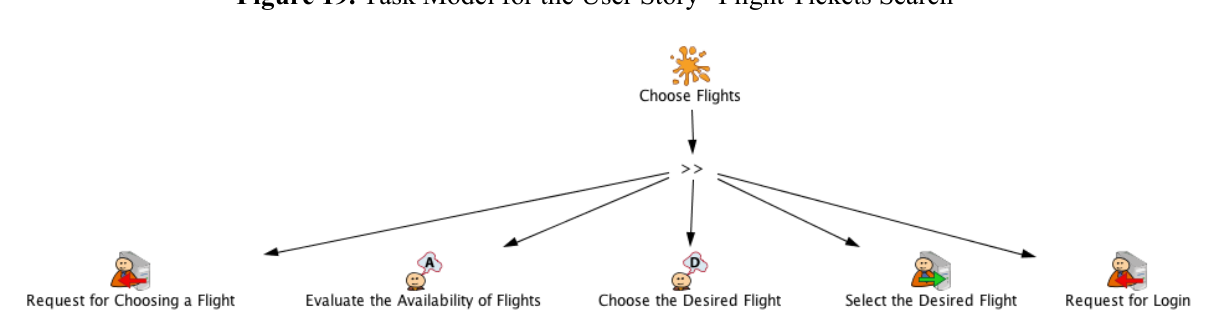
Figure 19. Task Model for the User Story “Flight Tickets Search”